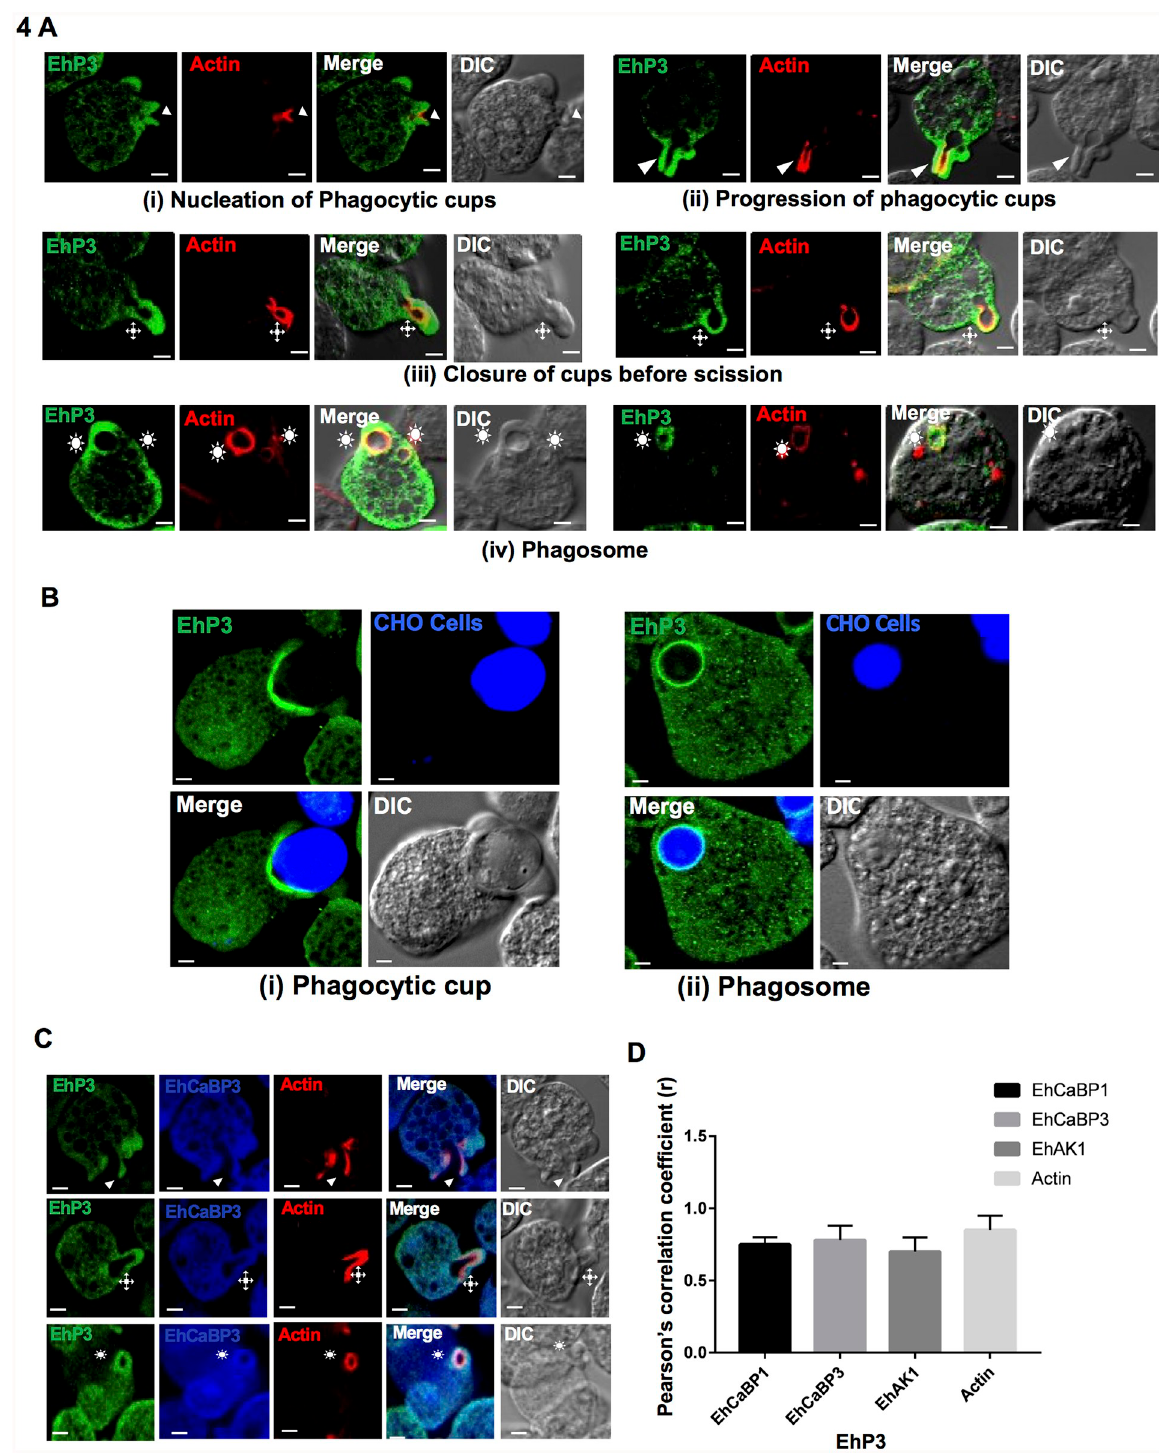
Fig 4. Immunolocalization of EhP3 in fixed trophozoites during phagocytosis of RBCs and CHO cells. (A) Localization of EhP3 during different stages of phagocytosis of RBCs. E . histolytica trophozoites actively phagocytosing RBCs were fixed and stained with EhP3 antibody and TRITC phalloidin (for visualisation of F-actin). Localization of EhP3 during different stages of phagocytosis are indicated as arrowheads (nucleation and progression of phagocytic cups), asterisks (closure of cup before scission) and stars (phagosomes). (B) Localization of EhP3